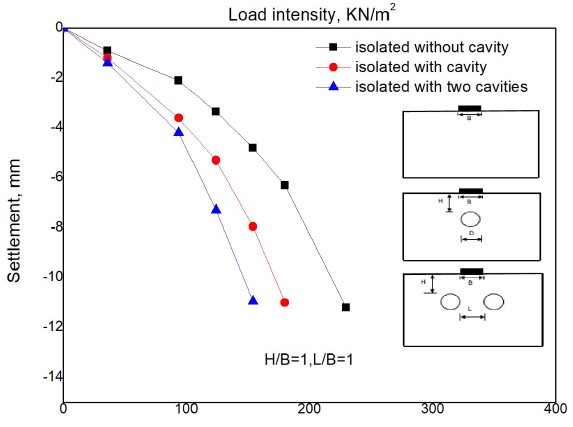
Figure 4: Load-settlement curve for cases of isolated footing and two strip footings; both cases rest on the surface of a sand layer without cavities.